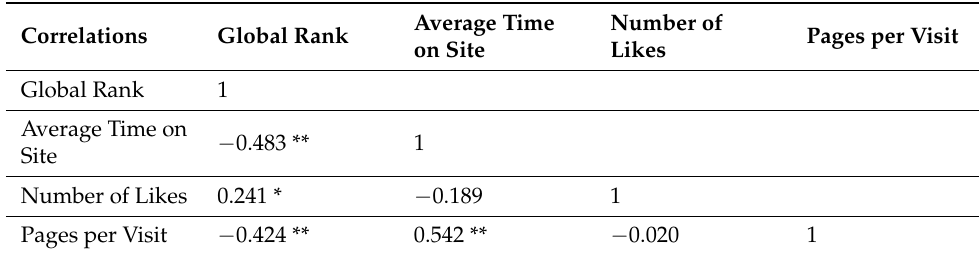
Table 10. Coefficients between the examined metrics for H5.